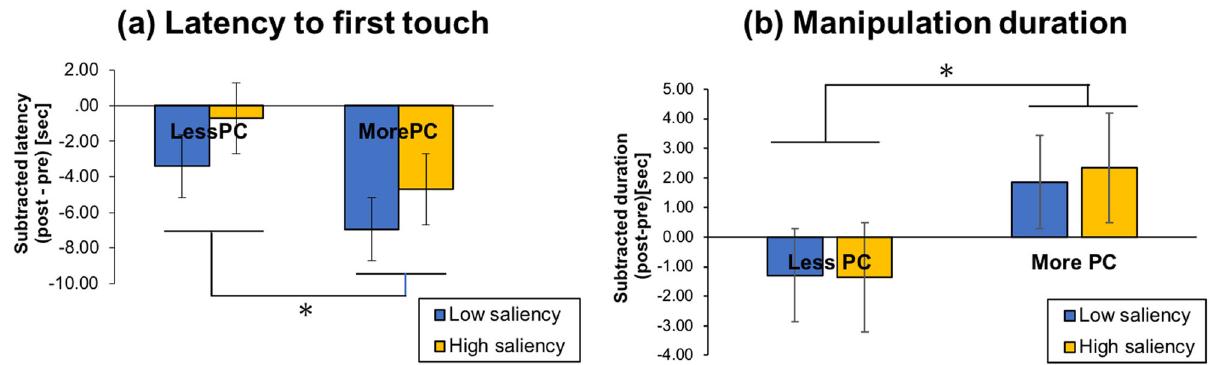
Fig. 2 The results of the Object Exploration Task. Change in a the latency to fi rst touch and b the duration of object manipulation during the Object Exploration Task; error bars show standard errors. * p <